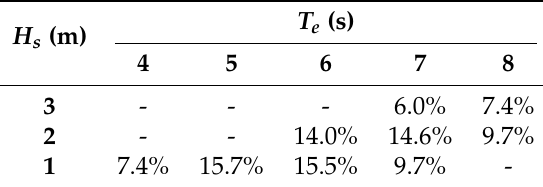
Table 1. Condensed wave climate scatter diagram at the Wave Hub site.